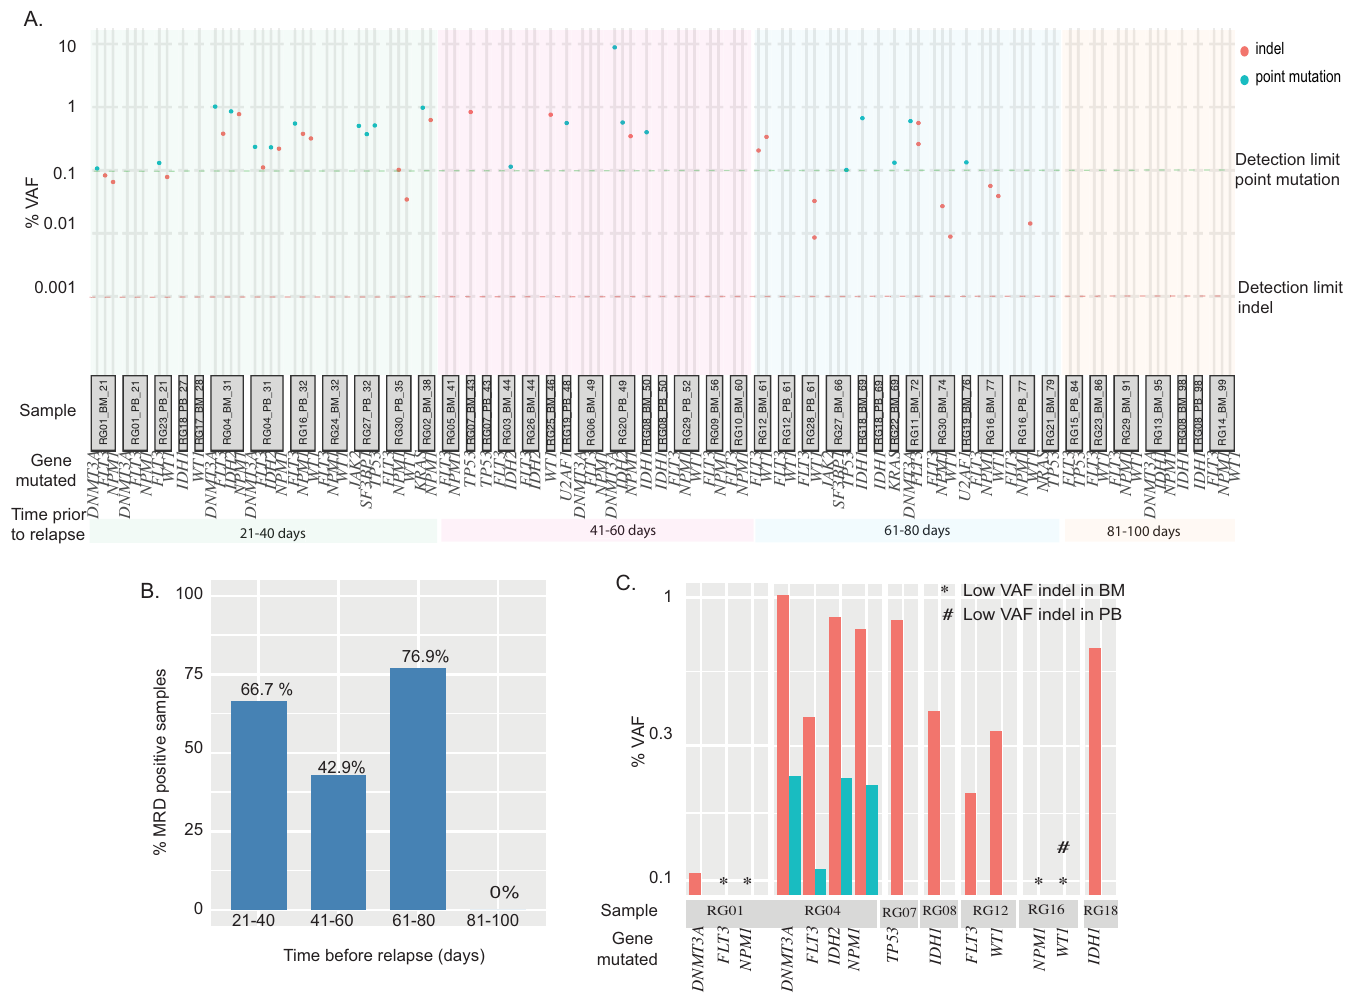
Fig 4. Early detection of relapse in RG patient samples using error-corrected NGS. (A) Shown are the results from MRD testing of all RG samples collected < 100 days before relapse. Each sample ID (gray box) is identified with RG number, source (PB or BM) and days before relapse. VAF cutoffs of 0.1% and 0.001% were used for point mutants (green dotted line) and indels (red dotted line). Genes with trackable pathogenic variants detected at relapse are listed for each sample. The samples are grouped into four bins (21–40, 41–60, 61–80, and 81–100 days prior to relapse) and color-coded as green, pink, blue and orange, respectively. (B) Summary (bar plot) of MRD detection rate for samples from each bin (21–40, 41–60, 61–80, and 81–100 days) (C) VAF of trackable mutations from time-matched PB and BM samples (7 patients).